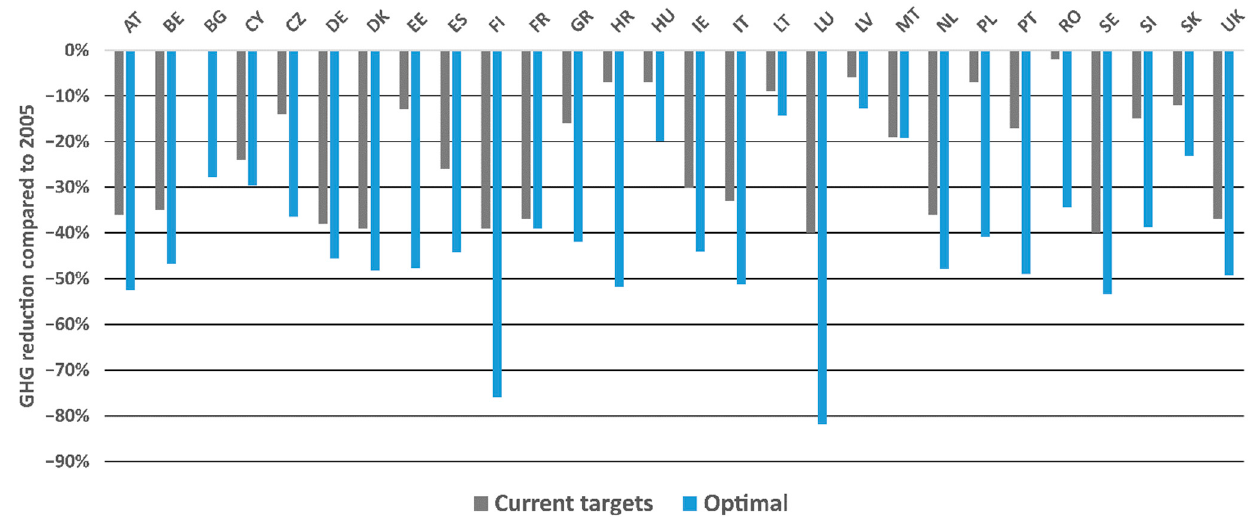
Figure 6. Country specific greenhouse gas reduction in the ESR sector against 2005 in the Optimal scenario in 2030 compared to the current targets, agreed in the Effort Sharing Regulation.